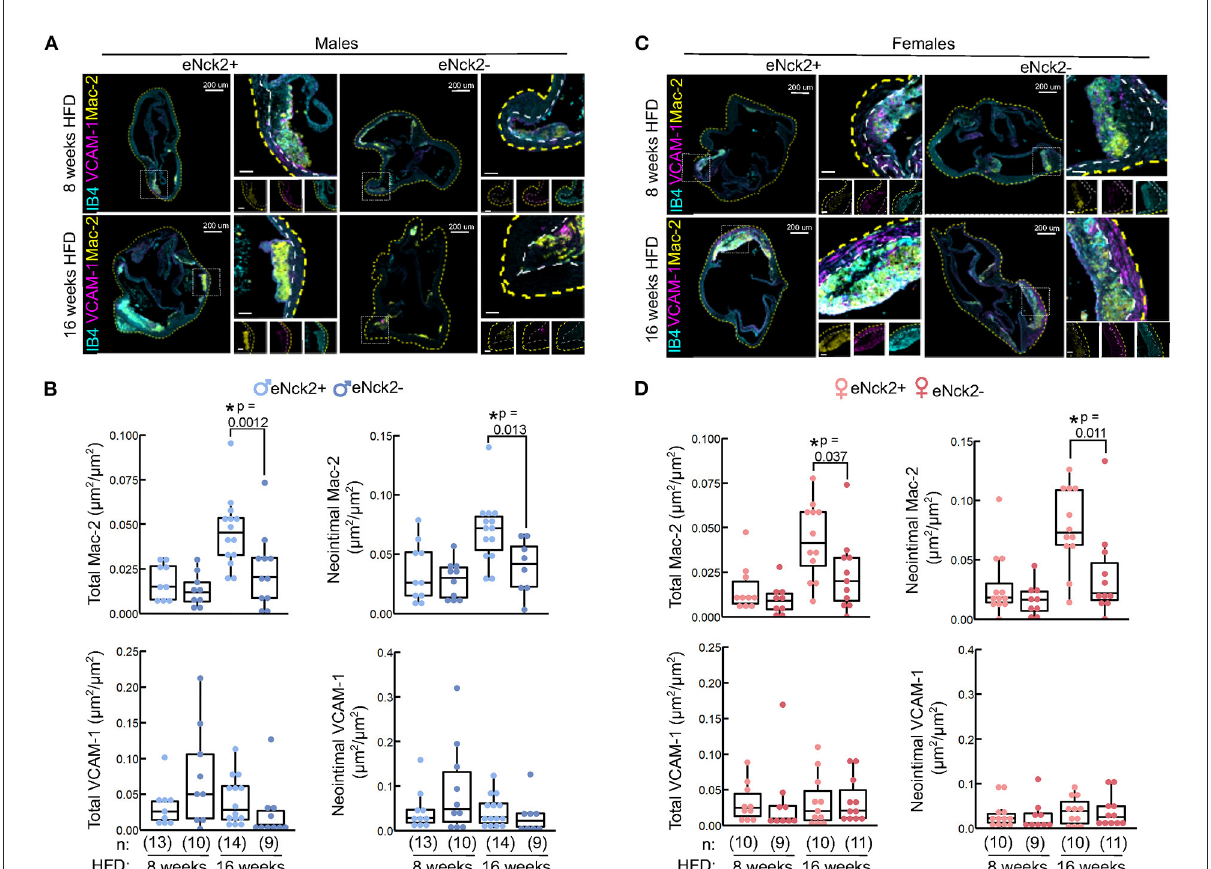
FIGURE4 Inflammation in aortic roots obtained from atheroprone mice with or without endothelial-specific deletion of NCK2. Animals were fed a HFD for 8 or 16 weeks to assess atherosclerotic lesion initiation and progression, respectively. (A,C) Representative confocal images of aortic roots showing immunofluorescence staining of the cell adhesion (VCAM-1) and leukocyte infiltration (Mac-2) markers in males (A) and females (C) . The dotted yellow and white lines contour the aortic root section and the neointima, respectively. The scale bars represent 50 µ m unless otherwise indicated. (B,D) Box plots displaying quantification of total Mac-2 or VCAM (left panels) and neointimal Mac-2 or VCAM-1 (right panels) in males (B) and females (D) . Total Mac-2 and VCAM-1 were calculated as Mac-2 or VCAM-1 area in entire root/root area. Neointimal Mac-2 and VCAM-1 were calculated as Mac-2 or VCAM-1 area in the neointima/area of neointima. Dots represent individual animals and the number of animals per group ins indicated in parentheses. Statistical significance was determined by Wilcoxon Rank Sum Test with Bonferroni correction. * p <